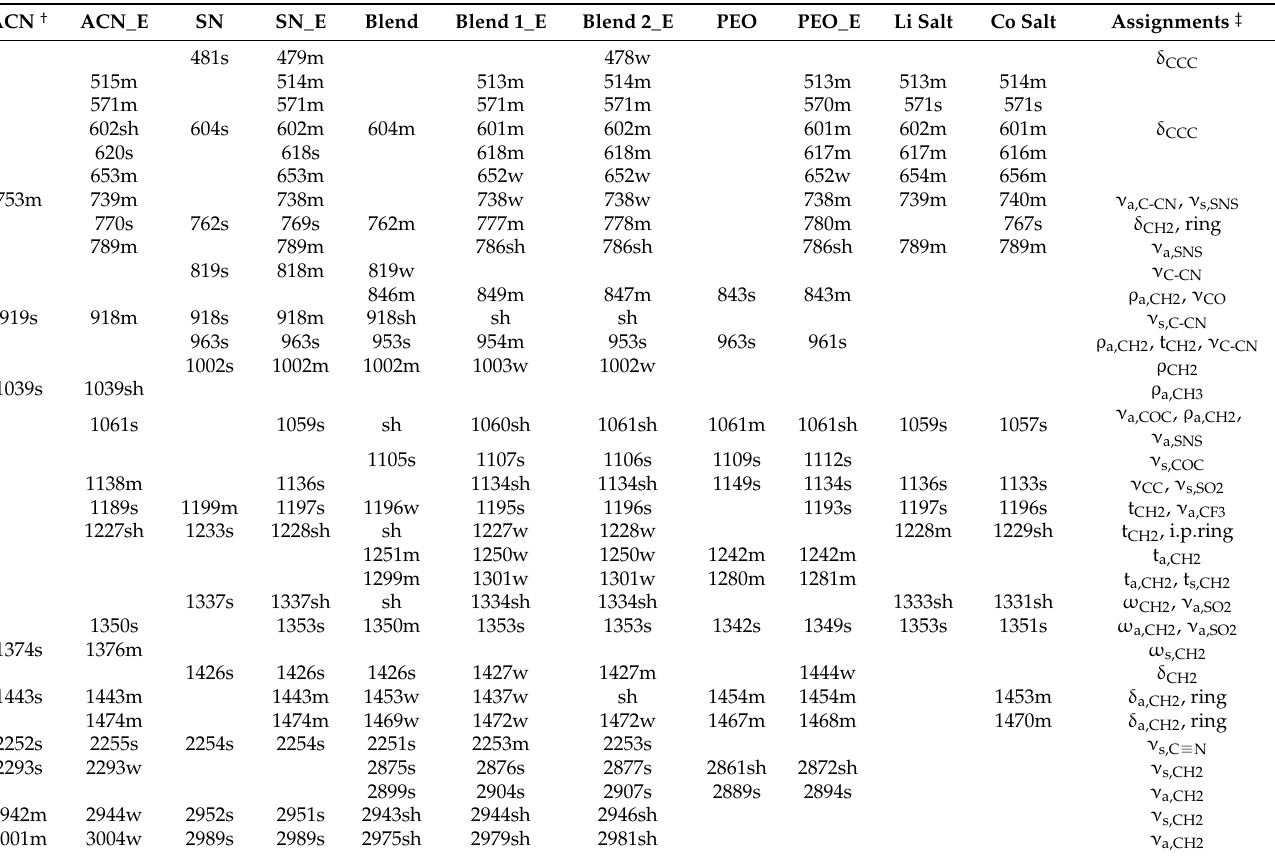
Table 2. Observed vibrational frequencies (in cm − 1 ) of the redox mediators, ACN_E, SN_E, PEO_E, and Blends 1_E & 2_E along with those of solvent/matrices and ionic